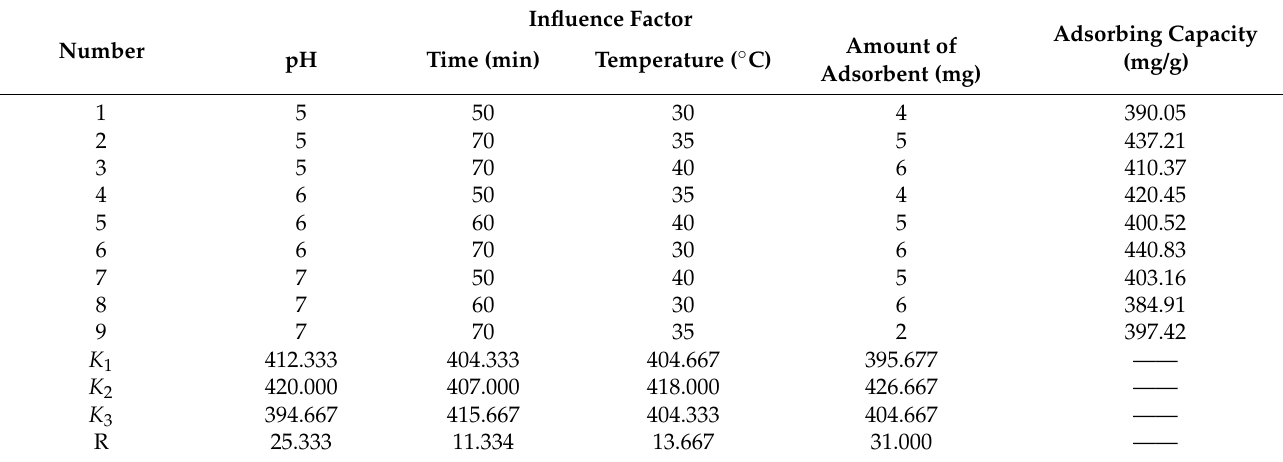
Table 2. The experimental results are intuitively calculated and